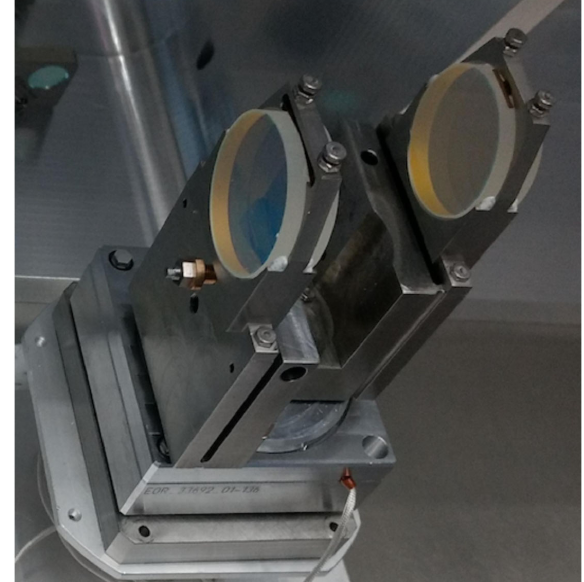
FIG. 9. Picture of a MPS ready to be installed under vacuum immediately after glueing, see text for details on the